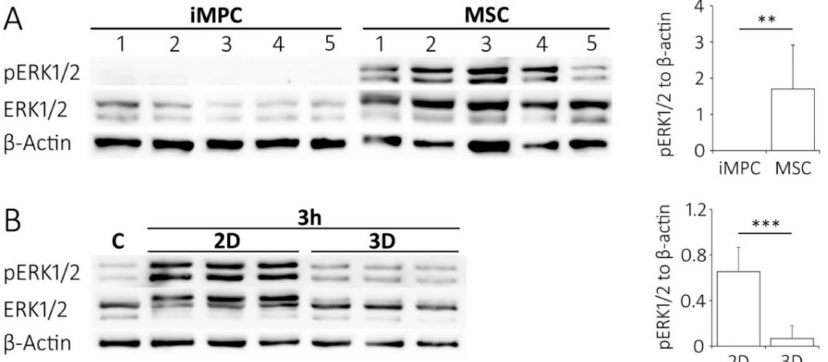
Figure 6. Western blot analysis of pERK1 / 2 levels in iMPCs and MSCs. ( A ) The expanded cells were harvested at passage 3 and pERK1 / 2 levels were analyzed by Western blotting using β -actin as loading control ( n = 5 independent iMPC populations 1–5 and MSC donor populations 1–5). Band intensities were quantified by densitometry. ( B ) The expanded cells were harvested at passage 2 and analyzed for pERK1 / 2 expression in cell suspension as a control (c) or 3 h after shift to monolayer (2D) or agarose culture (3D). The band intensities were quantified by densitometry ( n = 3 MSC donor populations with 3 technical replicate cultures each). (Mean ± standard deviation; ** p < 0.01, *** p < 0.001 between groups, Mann-Whitney